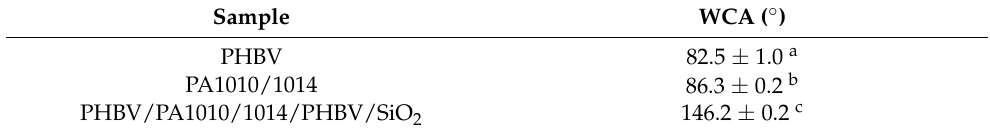
Table 5. WCA values of the mono- and multilayer films of PHBV, PA1010/1014, and SiO 2 microparticles.